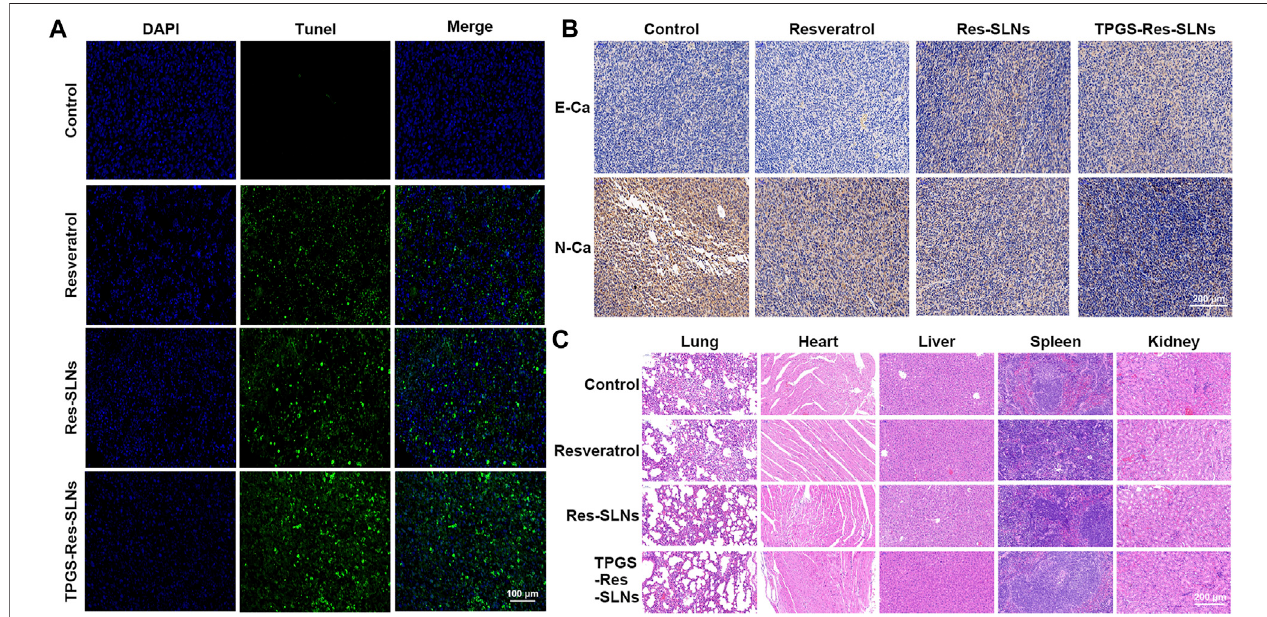
FIGURE8| TheantitumoreffectofTPGS-Res-SLNsonSKBR3/PRtumorbearingBALB/cnudemice. (A) ApoptosisdetectionbyTUNELassayinslicesoftumors collectedfromdifferentgroupsofmicetwodays aftertheend oftheindicatedtreatments.Originalmagni fi cation × 400. (B) IHC stainingofE-cadherin(E-Ca), N-cadherin (N-Ca), and positive cells of differently treated subcutaneous tumor. (C) H 8 E staining of vital organs of SKBR3-bearing nude mice after intravenous injection of PBS, Resveratrol, Res-SLNs and TPGS-Res-SLNs.